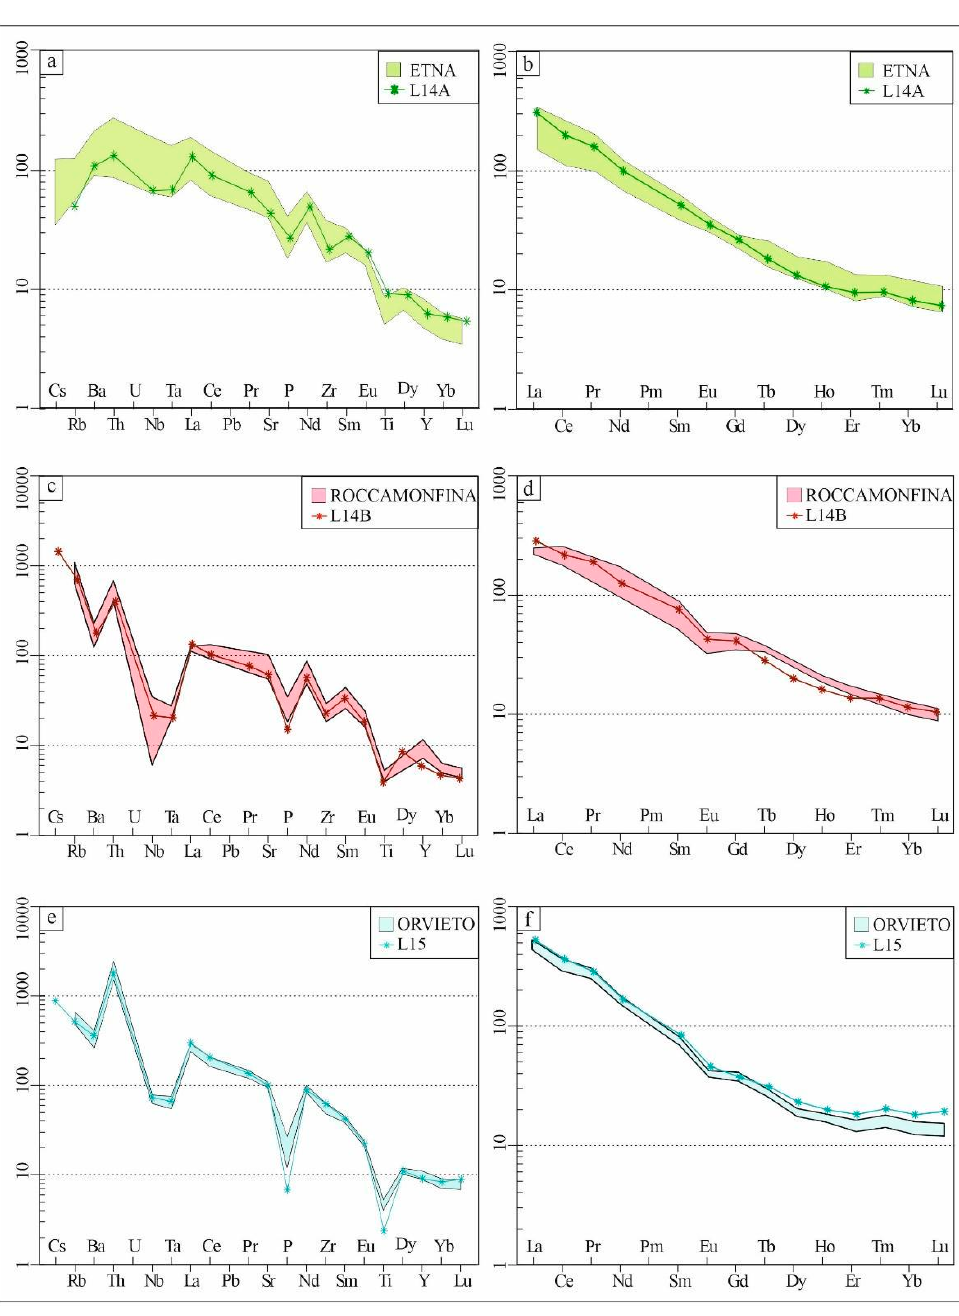
Figure 5. ( a , c , e ) Spider diagrams of elements normalized to primitive mantle and ( b , d , f ) REE chondrite, normalized, comparing investigated samples with statistically selected rock composition from the Etna, Roccamonfina, and Orvieto districts. Sample L 14A has a flat or semi-bell-shaped trend of LILE and HFSE ranging from >100 mn for LILEs, LREE, and HFSE3+, between 100 and 10 for HFSE4+5+, and lower than 10 for HREE. A slight negative anomaly of P and Ti and a large Pb-positive anomaly is apparent. The plot of REE has a La/Luch equal to 26.6, with a slight Eu